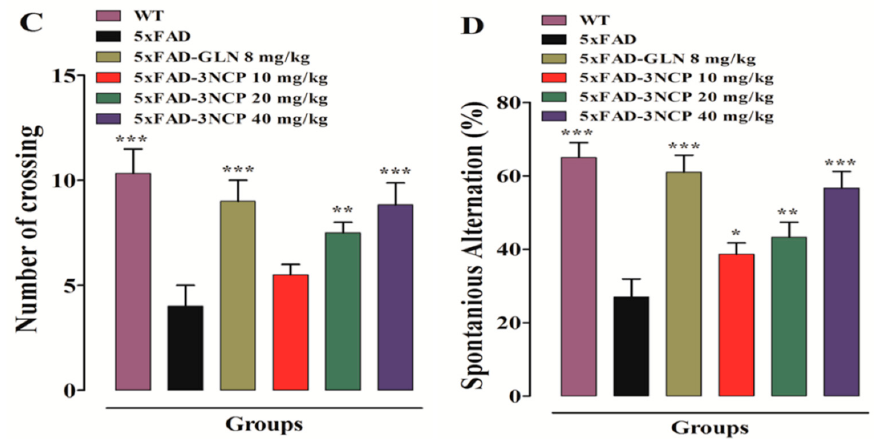
Figure 4. The effect of 3NCP on escape latency in MWM ( A ), time in target quadrant in probe test of MWM task ( B ), number of target crossing in probe test ( C ), and the effect of 3NCP on SAB in the Y-maze test ( D ). Bars express mean ± SEM. * p < 0.05, ** p < 0.01, *** p < 0.001 compared to 5xFAD group, ## p < 0.001 and ### p < 0.001 compared to non-transgenic WT group. Data was analyzed by two-way ANOVA followed by Bonferroni test, and one-way ANOVA followed by Tukey’s post-hoc test ( n = 10 mice / group).